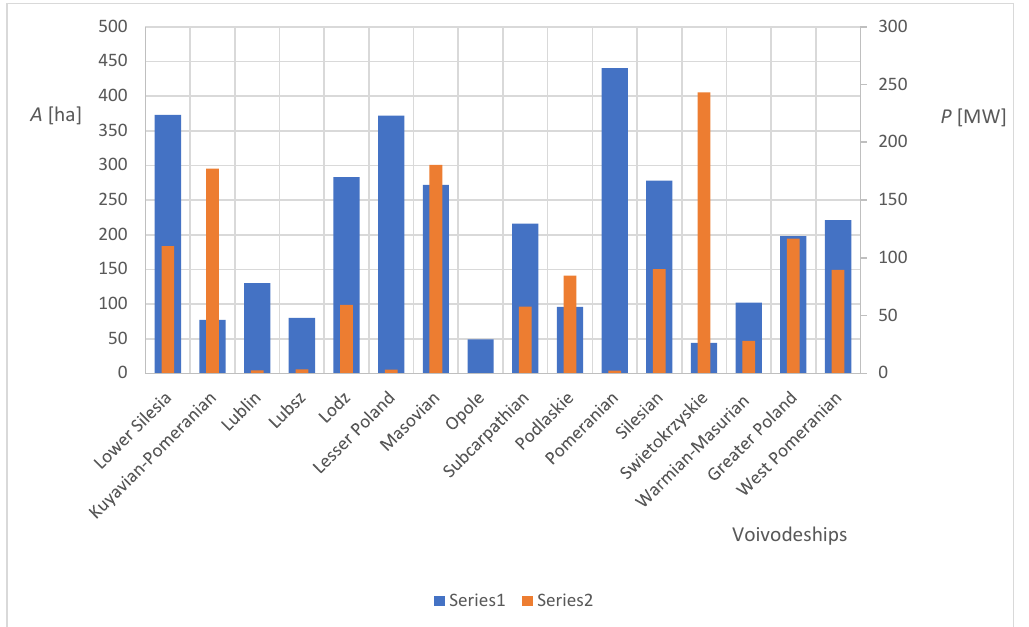
Figure 10. The relationship between the area of agricultural land potentially useful for the cultivation of energy crops (as of 2021) and the regional approach to the installed power from biomass in Poland (own elaboration).